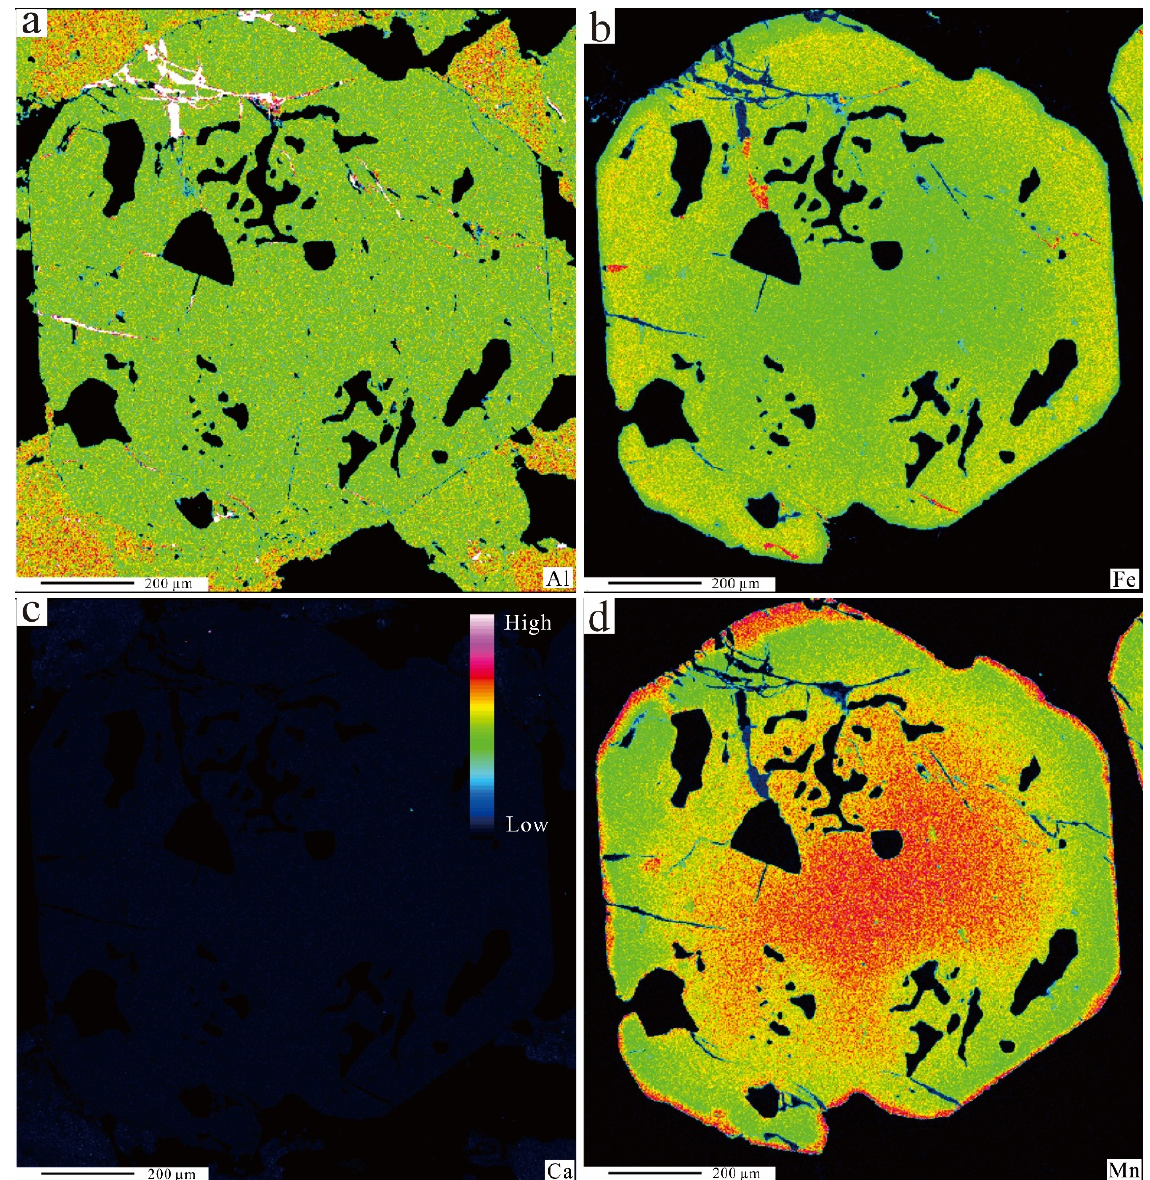
Figure 9. Element maps of Al ( a ), Fe ( b ), Ca ( c ), and Mn ( d ) for the garnet CND–03–a from the muscovite granite.